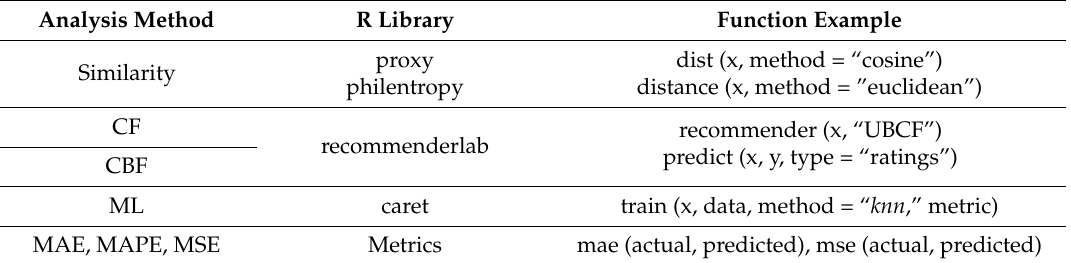
Figure 7. Screenshot of results of MAE, MAPE, and MSE in R. Table 5. R library for analysis and prediction of experiments.